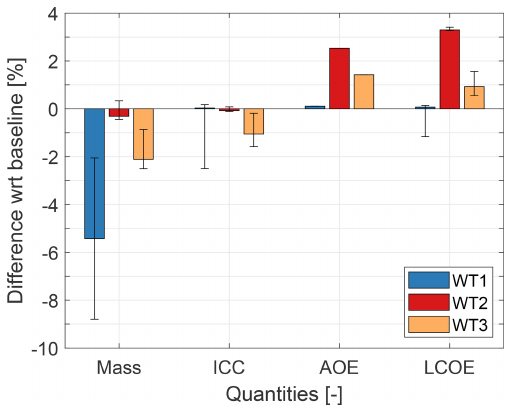
Figure 9. Effects of LAC on the redesign of the rotor with respect to the initial baselines. Solid bars: load-reduction model of Table 2; whiskers: range of the pessimistic and optimistic